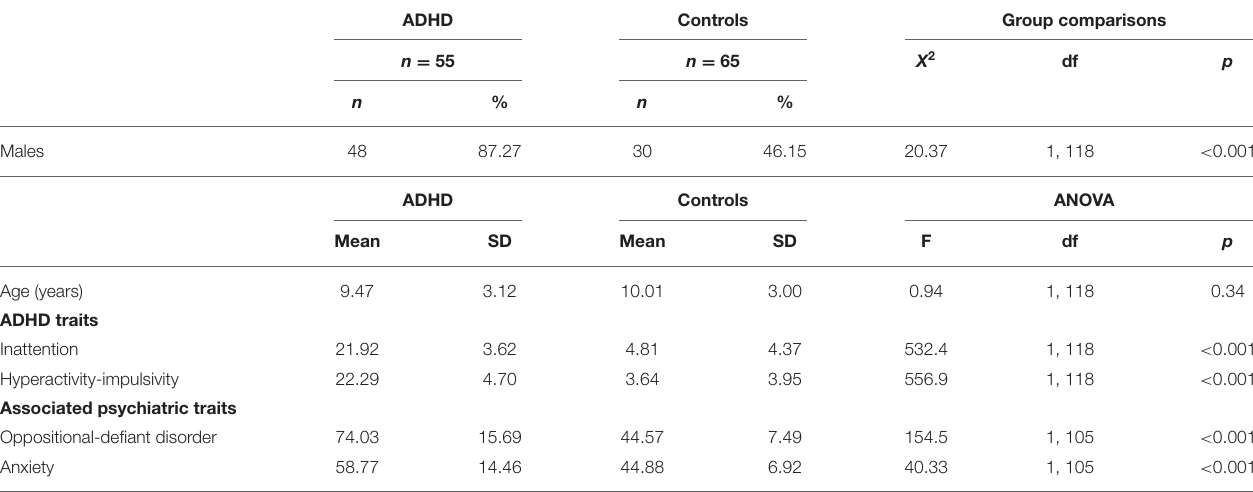
TABLE 1 | Sample characteristics.